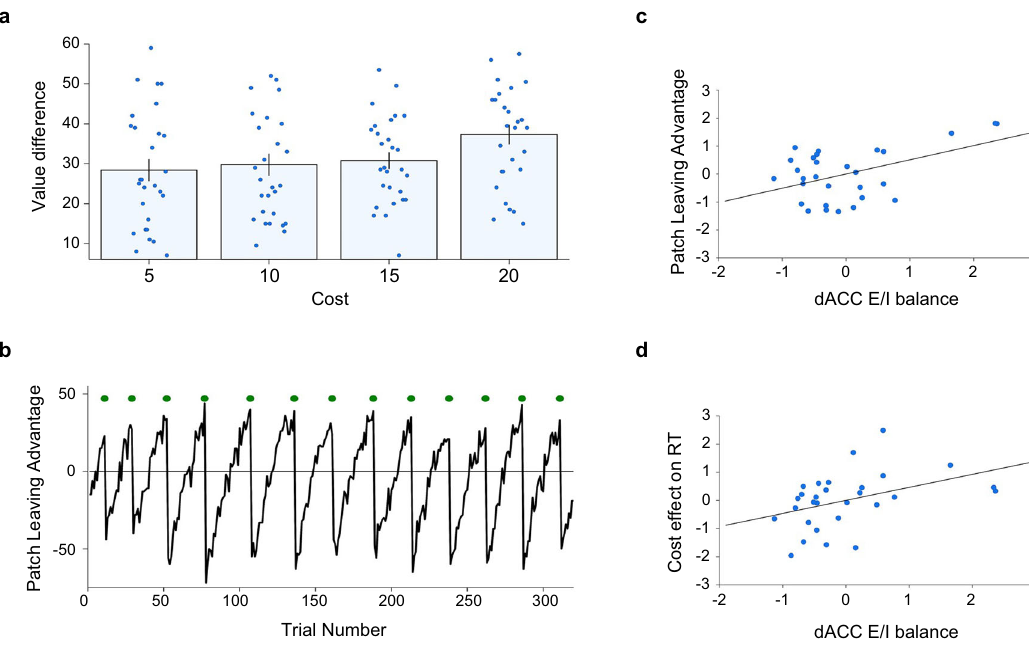
Fig. 2 Patch-leaving behaviour and cortical E/I balance. a Participants left their current patch at higher value differences (alternative − current patch value) when leaving was associated with higher costs (RM-ANOVA: F 3,81 = 5.941, p = 0.001, η 2 = 0.063, N = 28). Individual data points are overlaid as dot plots. Bars represent across-participants mean of the median per cost level. Error bars indicate standard error of the mean. b Example timecourse of patch- leaving advantages (PLA) for one example participant. PLA = [value alternative patch − value current patch − cost]. Green circles indicate patch-leaving trials. c Participants with higher dACC E/I balance leave at higher average PLA (Pearson correlation on residuals (compare main text and methods): r = 0.483, p = 0.008, CI = [0.141 – 0.722], N = 29). d Participants ’ patch-leaving decisions are slowed down with increasing cost levels, and this effect is 95 most pronounced in participants with high levels of dACC E/I balance (Pearson correlation on residuals: r = 0.415, p = 0.025, CI 95 = [0.057 – 0.678], N = 29). Source data are provided as a Source data fi signi fi cant in fl uence of E/I balance in dACC ( t 23 = 2.643, p =